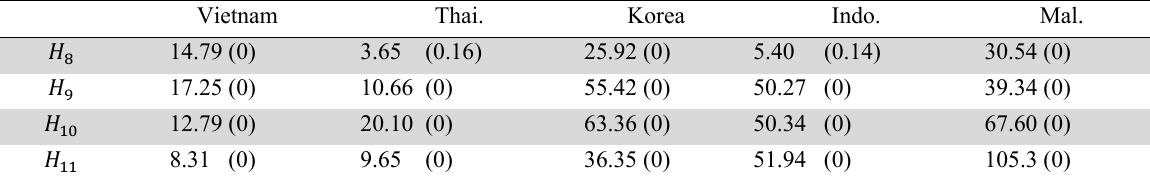
Results of exclusion restriction tests